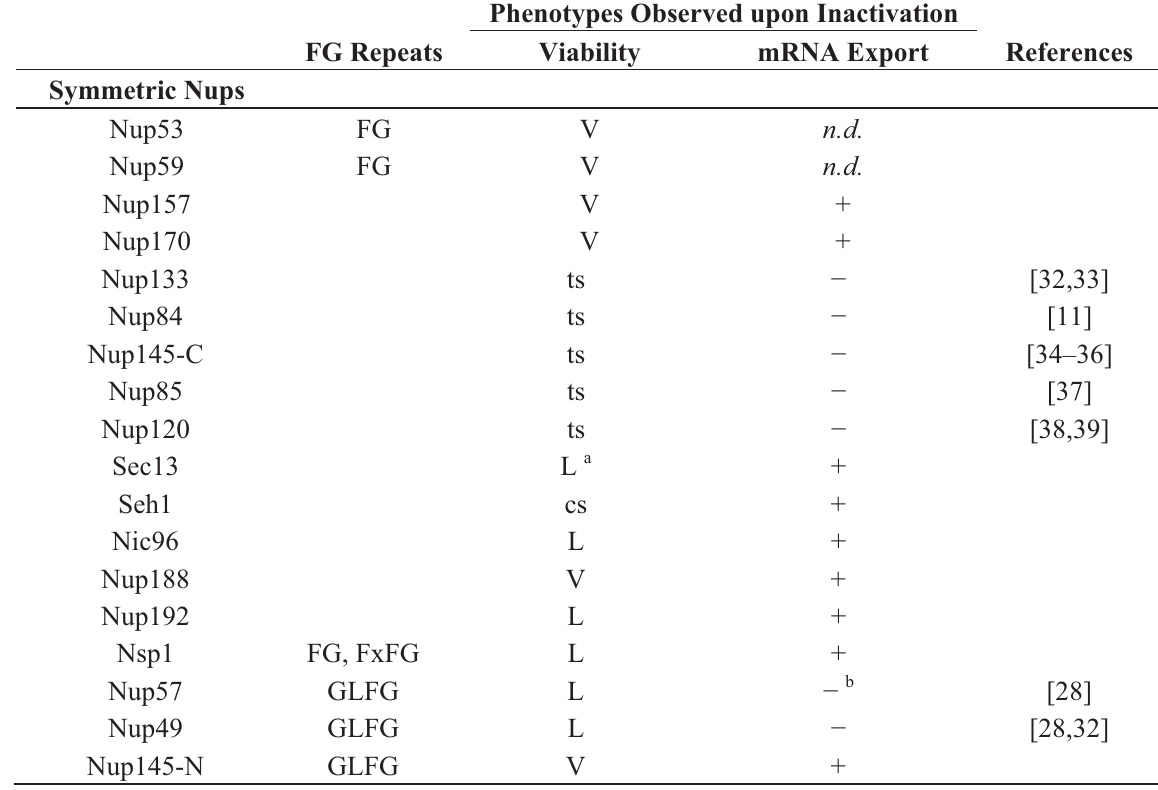
Table 1. Nucleoporins involved in mRNA export in